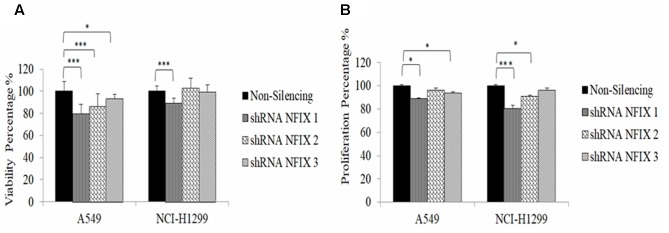
Cellular viability and proliferation activities were reduced in both cell lines at 48 h post-transfection with NFIX shRNAs. (A) A549 cell viability was decreased following transfection with all NFIX shRNAs. (B) NCI-H1299 cell viability was reduced only by NFIX_1shRNA. ∗p < 0.01; ∗∗∗p < 0.05.